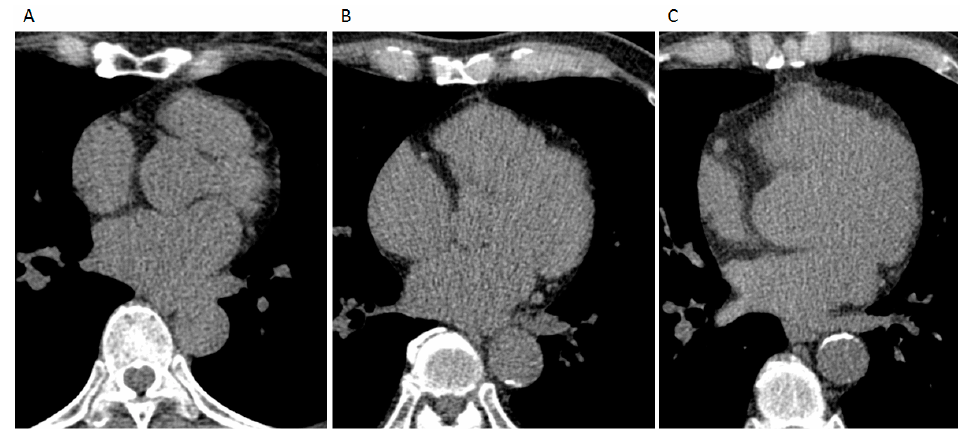
Figure 1. Non-enhanced, ECG-gated cardiac MDCT images revealed ( A ) no calcification of thoracic aorta in a patient with normal blood pressure (NBP), ( B ) mild calcification in a patient with elevated blood pressure (EBP), and ( C ) moderate to severe calcification in a patient with severe hypertension (S2 HTN), according to the 2017 ACC/AHA HTN guidelines.